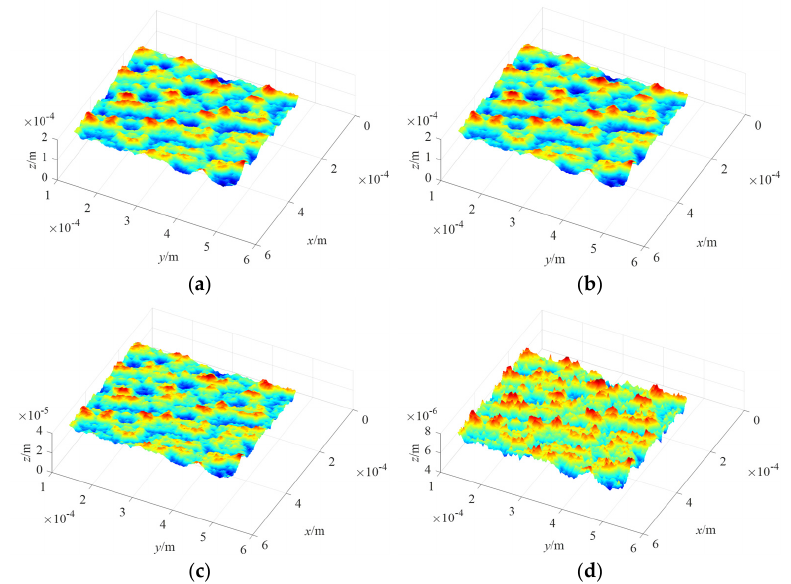
Figure 2. Generated rough surfaces with different D s values: ( a ) D s = 2.2; ( b ) D s = 2.4; ( c ) D s = 2.6; ( d ) D s = 2.8.